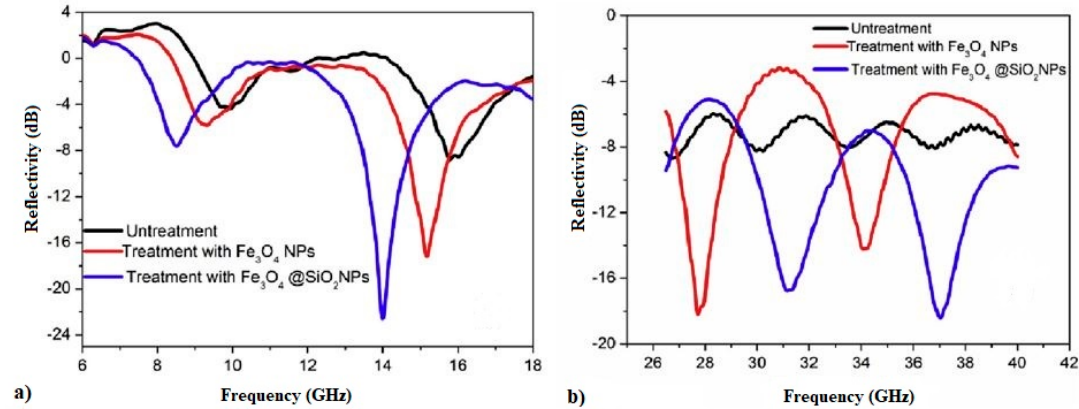
Figure 22. The reflectivity of cement mortar treated with Fe 3 O 4 and Fe 3 O 4 /SiO 2 nanoparticles (NPs) at ( a ) 6–18 GHz and ( b ) 26–40 GHz (Reprinted with permission from [104]. Copyright 2017 Elsevier).